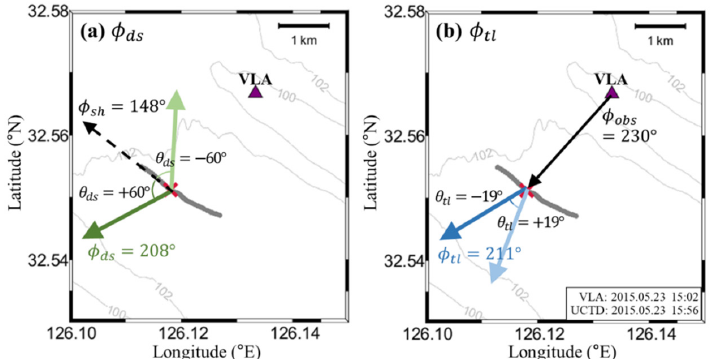
Figure 6. Propagation direction of NLIW observed during the SAVEX15, estimated from ( a ) Doppler shift method and ( b ) time lag method. The φ sh , φ obs , θ ds , and θ tl are labelled in the plots. Date and times of the corresponding events are noted in the right bottom corner.